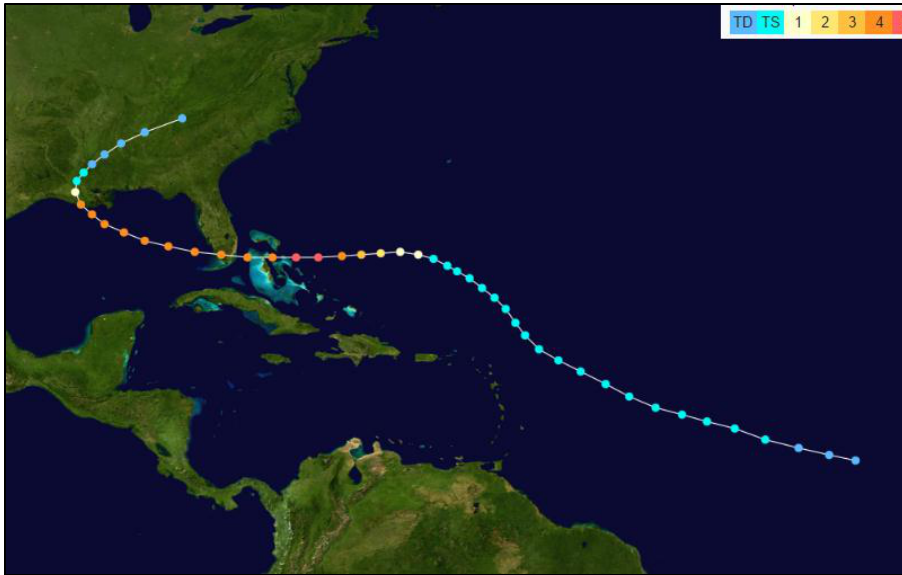
Figure 11. Track of Hurricane Andrew (1992).